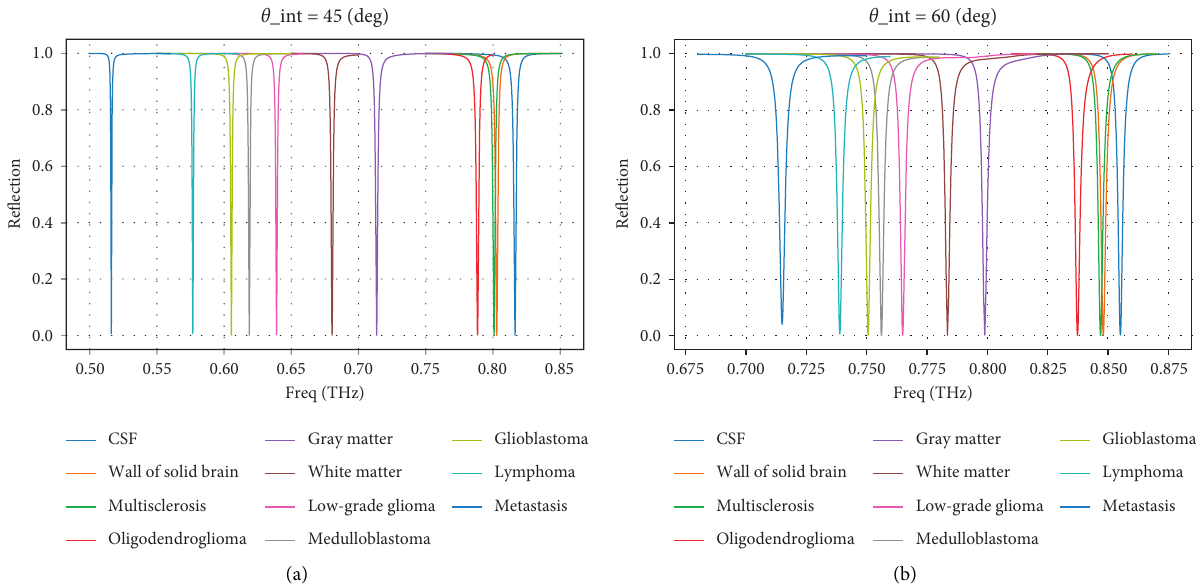
Figure 8: The reflection spectrums when the sample layer is filled with different types of brain cancerous cells at θ